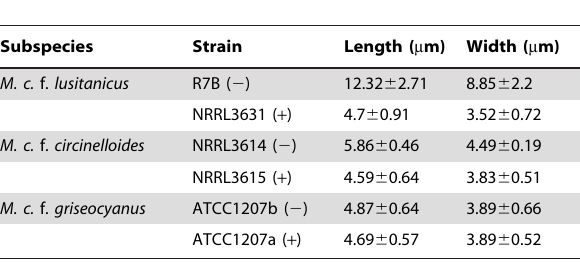
Average spore sizes (n=100).